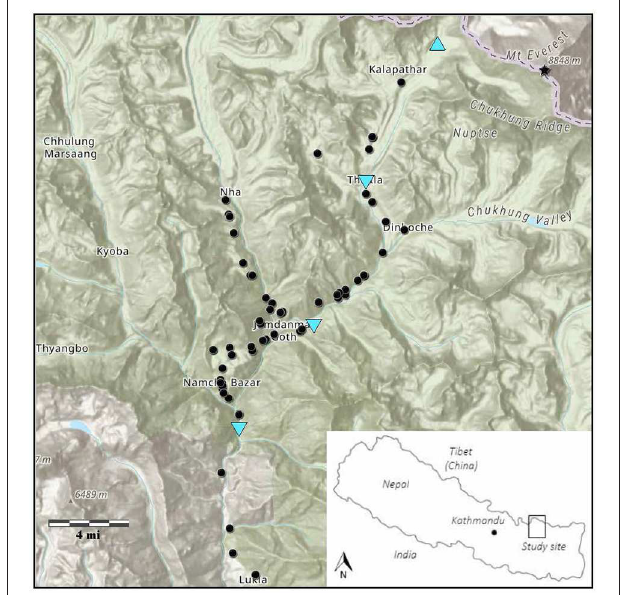
FIGURE 1 | Map of Khumbu Valley; point-up triangle represents glacial melt sample; point-down triangles represent rain samples; circles represent all other sampling locations; inset map shows location of study area within